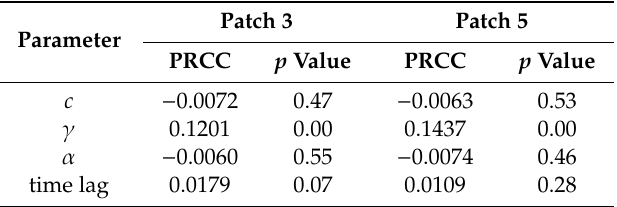
Table 4. Partial rank correlation coe ffi cient (PRCC) between the likelihood of virus translocating to Patch 3 or Patch 5 and environmental transmission parameters and time